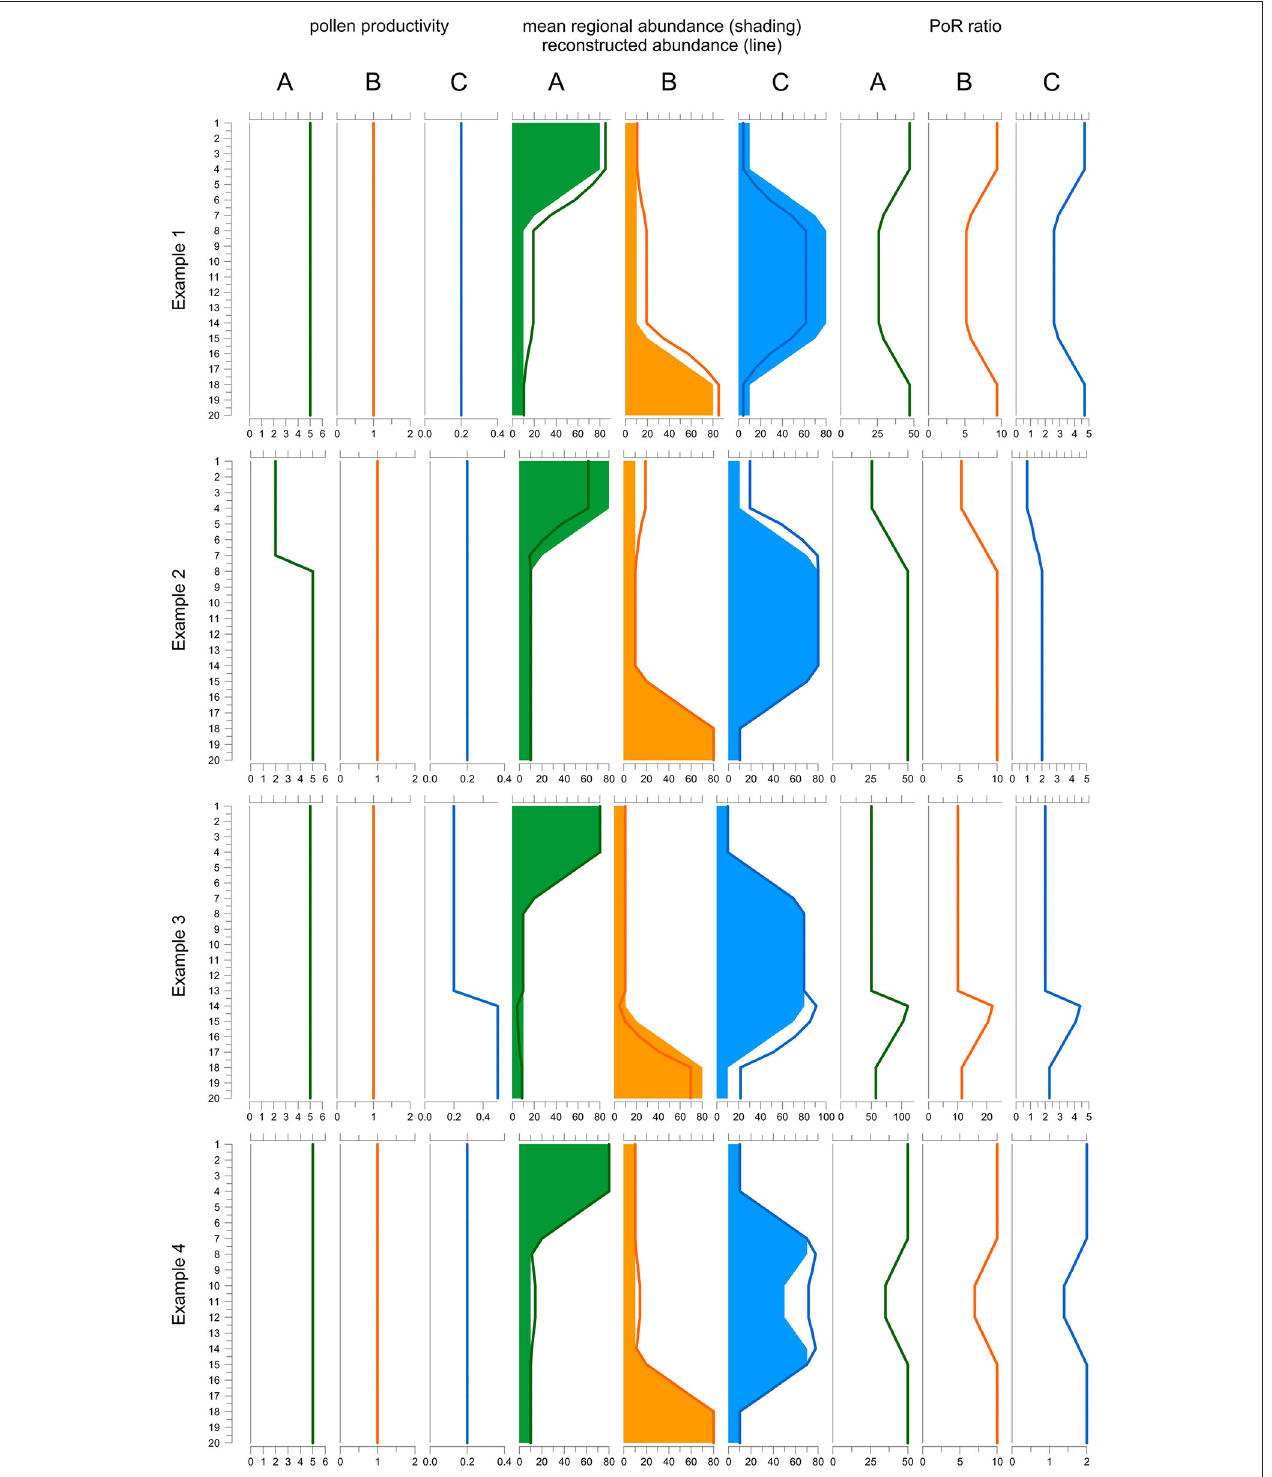
FIGURE 1 | Behavior of the PAR over REVEALS (PoR) ratio when one PPE is wrong (example 1), under changing pollen productivity (example 2 and 3) and under changing total regional plant abundances (example 4). The model includes three taxa A, B, and C over 20 time steps (y-axis): Taxon A (green) is dominant in the top part, B (orange) in the lower part and C (blue) in the middle part of the record. Default pollen productivity is 5 for A, 1 for B and 0.2 for C. Line graphs to the left depict